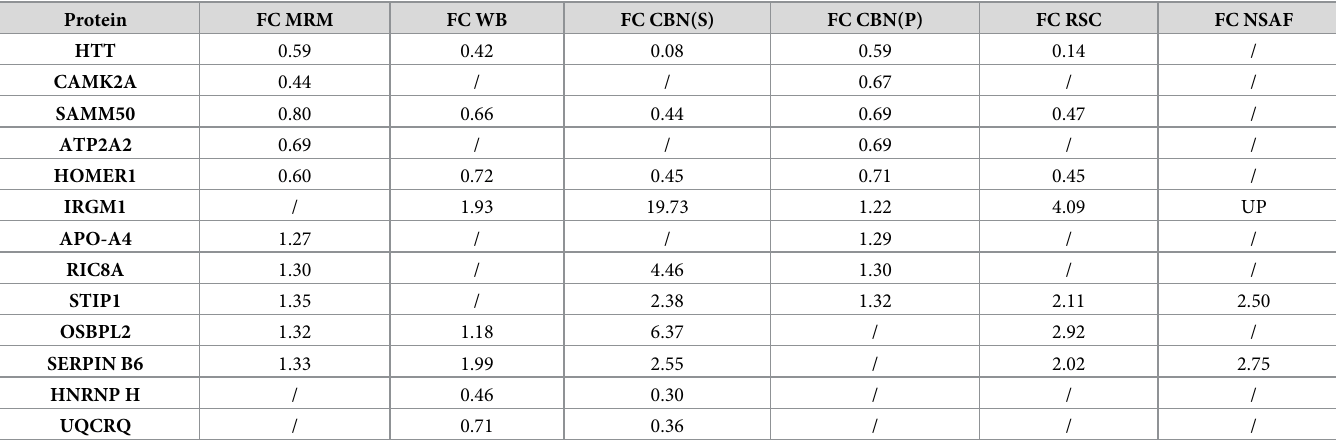
In the table proteins selected for validation and their FC values calculated by LF, MRM, and WB methods are